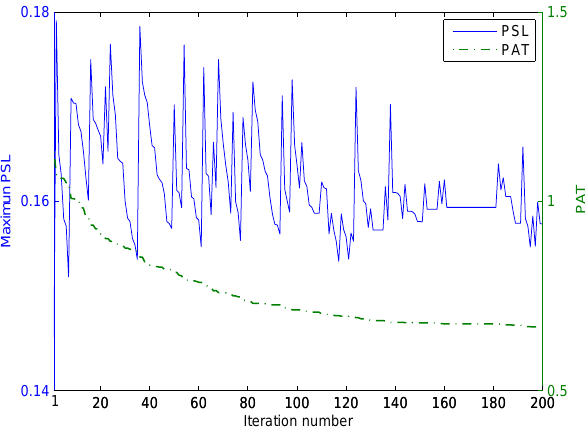
Figure 11. The iterative process of optimization in the second stage for the one-main-lobe.